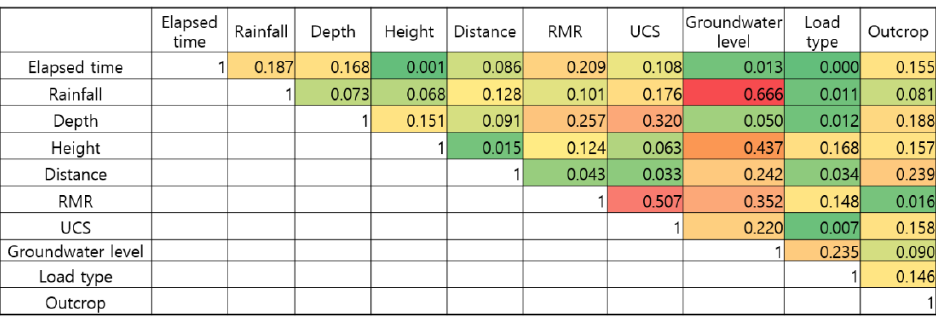
Figure 6. Correlation between influence factors and subsidence.